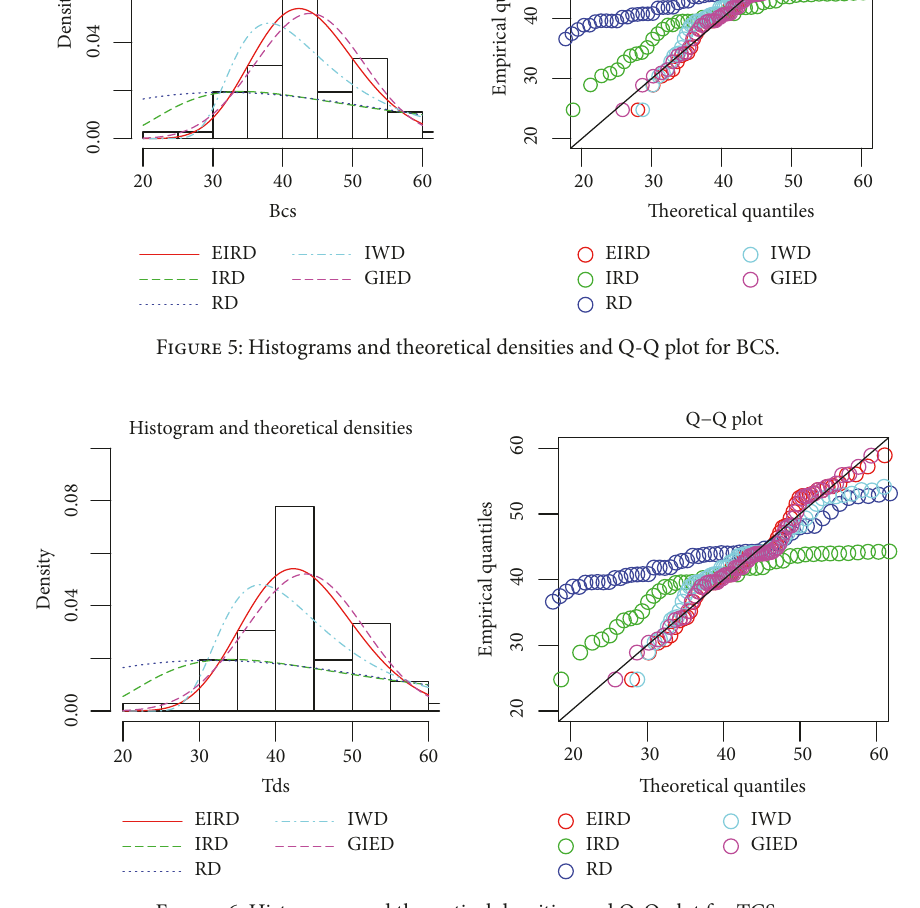
Figure 6: Histograms and theoretical densities and Q-Q plot for